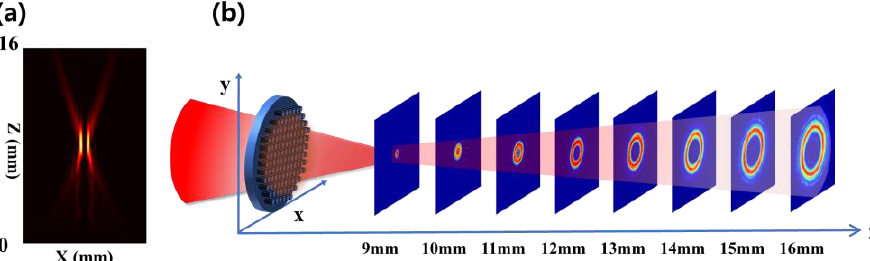
Figure 6 . ( a ) The intensity profiles in the x-z plane of the generated PVB with the parameters of d = 4 mm and l = 2. ( b ) Corresponding 2D cross-section images of the generated PVB at different longitudinal positions.